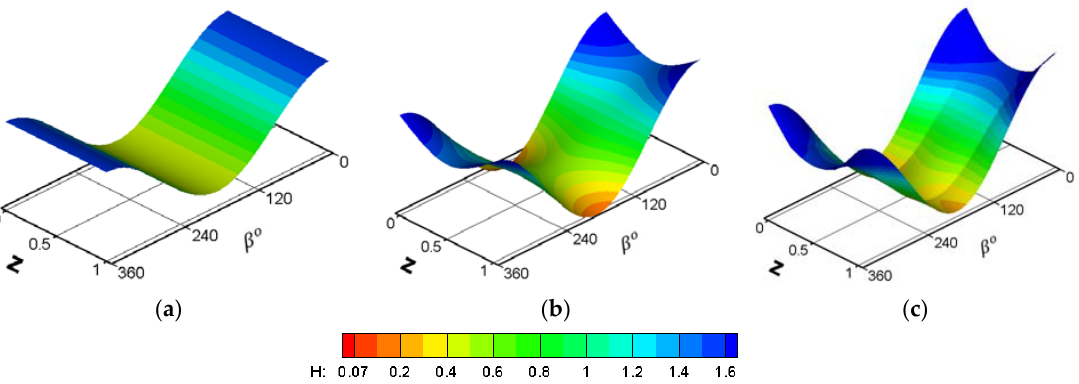
Figure 6. Three ‐ dimensional film thickness distribution (L/D = 1.25). ( a ) ∆ℎ (cid:3042) (cid:3404) ∆𝑣 (cid:3042) (cid:3404) 0 , ( b ) ∆ℎ (cid:3042) (cid:3404) Figure 6. Three-dimensional film thickness distribution ( L / D = 1.25). ( a ) ∆ h o = ∆ v o = 0, ( b ) ∆ h o = ∆ v ∆𝑣 (cid:3042) (cid:3404) 0.58 , and ( c ) Case ( b ) with chamfer ( 𝐴 (cid:3404) 𝐵 (cid:3404) 0.25 ). o = 0.58, and ( c ) Case ( b ) with chamfer ( A = B =